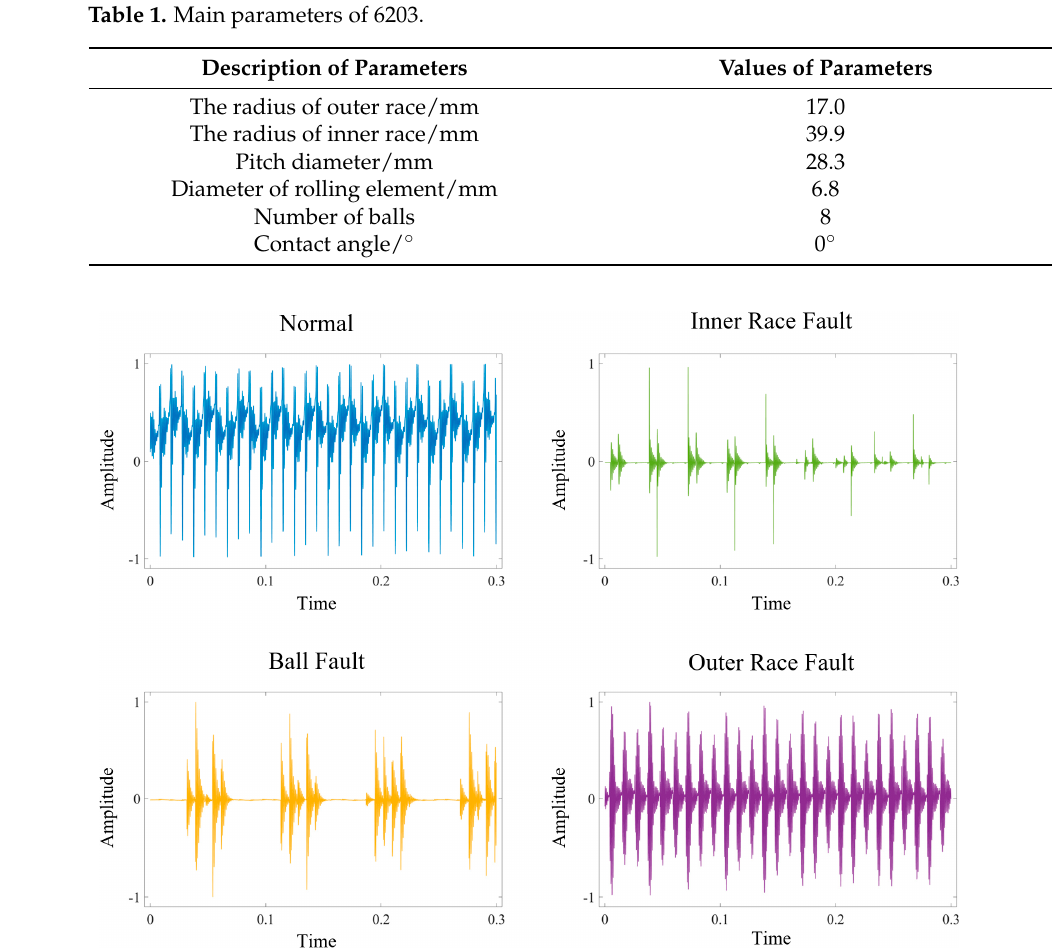
Figure 3. Time − domain waveforms of simulation data.